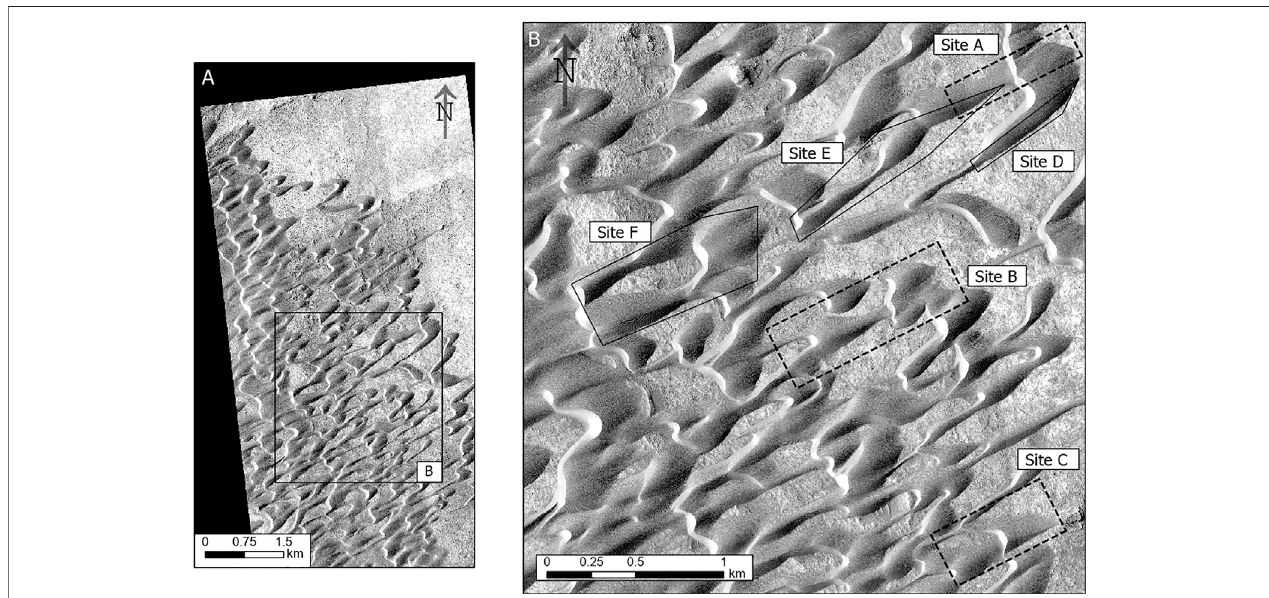
FIGURE2| HiRISEimage ofourstudyarea (A) including theimmediatevicinityofourstudysites (B) .Sites A-C,outlinedindashed rectangles,areprimarilyused in investigationsofwake fl ow( Ripple MigrationRatesonDunes ),andareas outlinesinsolidpolygons(D – F)areprimarilyused ininvestigations of2-Dripplesondune fl anks ( Wind Orientation ).